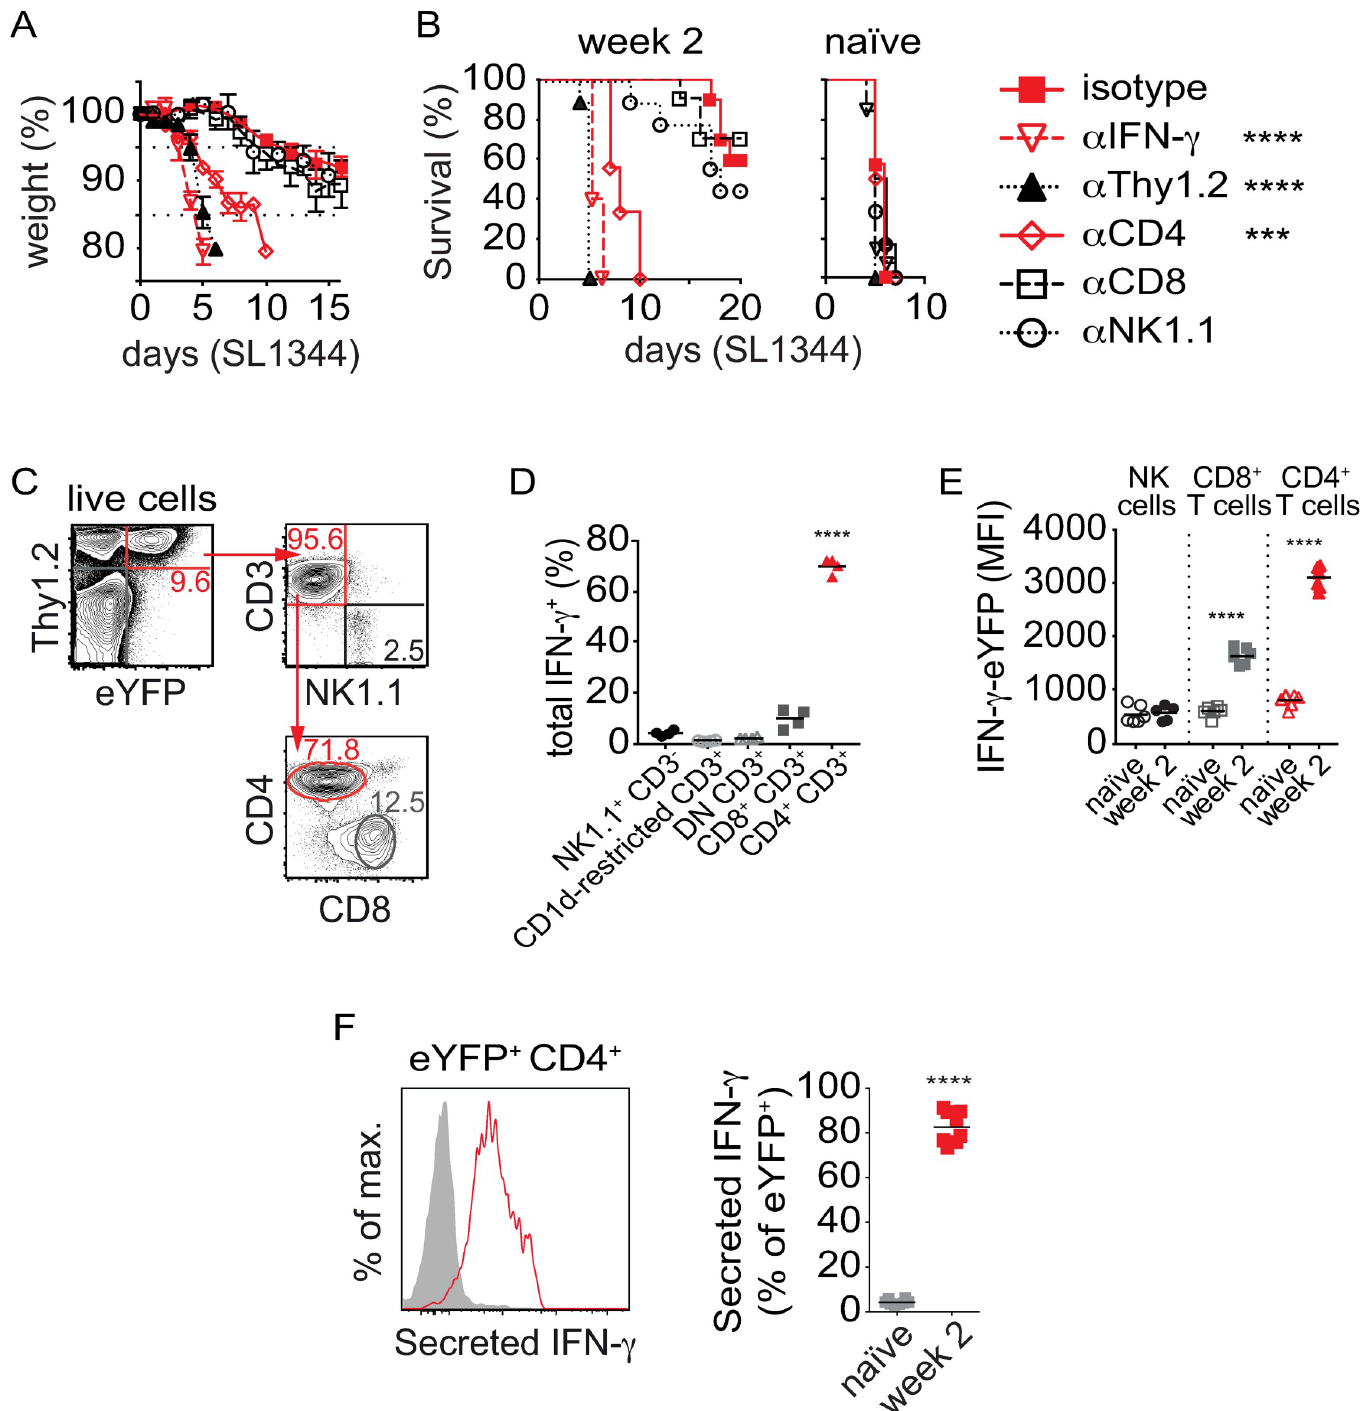
Fig 2. Adoptive protection from week 2 splenocytes is IFN- γ and CD4 + T cell-dependent. B6 or IFN- γ -eYFP in/in mice were either na ï ve or infected with 200CFU TAS2010 i.v. for 2 weeks. (A) Weight loss (expressed as a percentage of initial weight, group mean shown) and (B) percentage survival of Rag2 -/- Il2rg -/- recipient mice after receiving 5 × 10 7 splenocytes from na ï ve or week 2 p.i. B6 donor mice, i.p. injected with either isotype control, anti-Thy1.2, anti-CD4, anti-CD8 or anti-NK1.1 i.p. at the time of cell transfer, then challenged with 200CFU wild type SL1344 24 h after transfer (n = 9–10). Data are pooled from 2–4 independent experiments. Within week 2 p.i. donor splenocytes, (C) representative FACS plots and (D) percentage of the expression of IFN- γ -eYFP in different Thy1.2 + sub-populations and E) level of IFN- γ expression (expressed as MFI) identify CD4 + T cells are the main producer of IFN- γ . Each symbol represents a pool of donor cells from an independent experiment, data from 4–7 experiments are shown here with horizontal bar representing the mean for each sub-population, and one- or two-way ANOVA with Bonferroni post-tests was